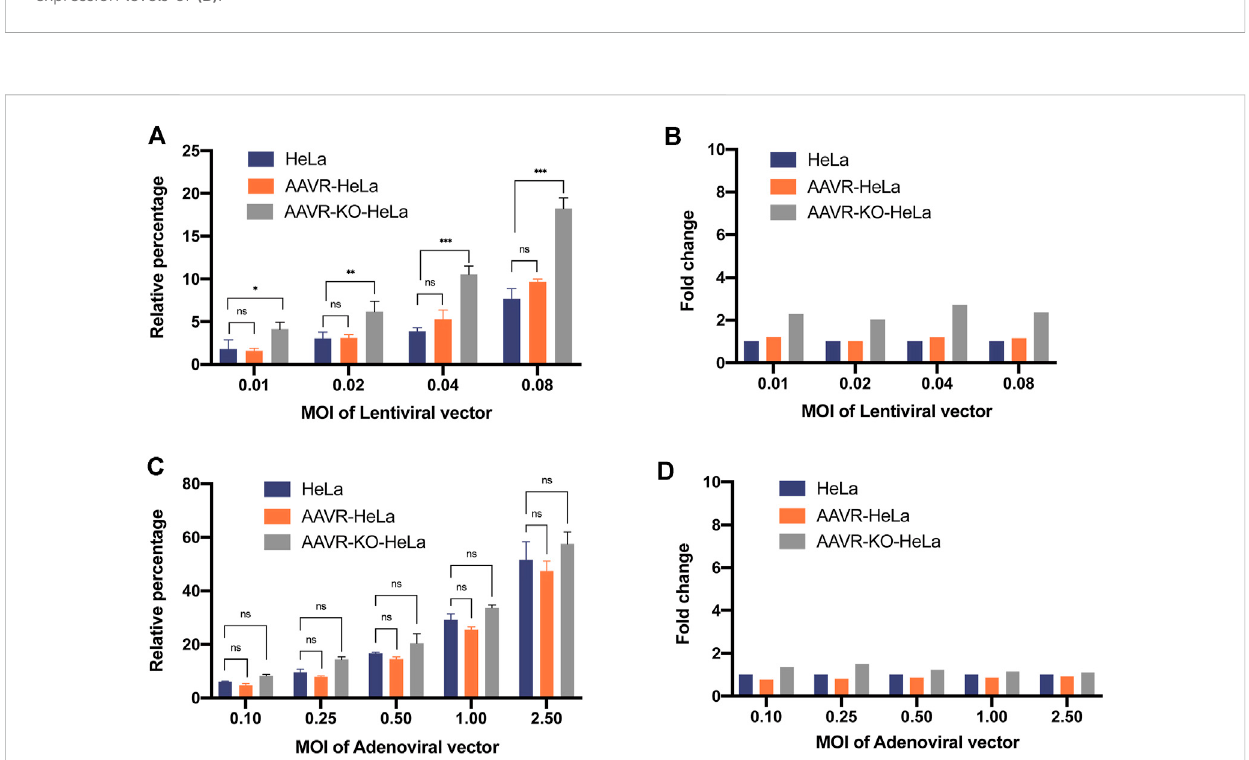
FIGURE 4 Analysis of the AAVR transduction speci fi city for lentiviral and adenoviral vectors. The cells were seeded onto 24-well plates and infected by a lentiviral or an adenoviral vector carrying EGFP at the relevant MOIs. EGFP-positive cells were counted by fl ow cytometry at 48 h post-infection. The results were presented as mean ± SD ( n = 3) and analyzed by GraphPad Prism version 8.4.0. ns, not signi fi cant; * p < 0.05; ** p < 0.01; *** p < 0.001. (A) Transduction ef fi ciencies of the lentiviral vector carrying EGFP in HeLa, AAVR-HeLa and AAVR-KO-HeLa cells. (B) Fold changes of the lentiviral vector carrying EGFP in AAVR-HeLa and AAVR-KO-HeLa cells compared to HeLa cells. (C) Transduction ef fi ciencies of the adenoviral vector carrying EGFP in HeLa, AAVR-HeLa and AAVR-KO-HeLa cells. (D) Fold changes of the adenoviral vector carrying EGFP in AAVR-HeLa and AAVR-KO-HeLa cells compared to HeLa